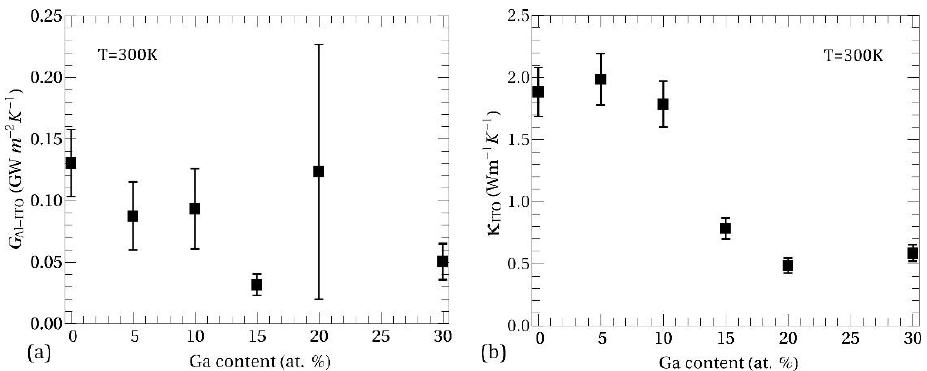
Figure 4. ( a ) Thermal boundary conductance across the Al-ITO interface. ( b ) Thermal conductivity of ITO thin films.